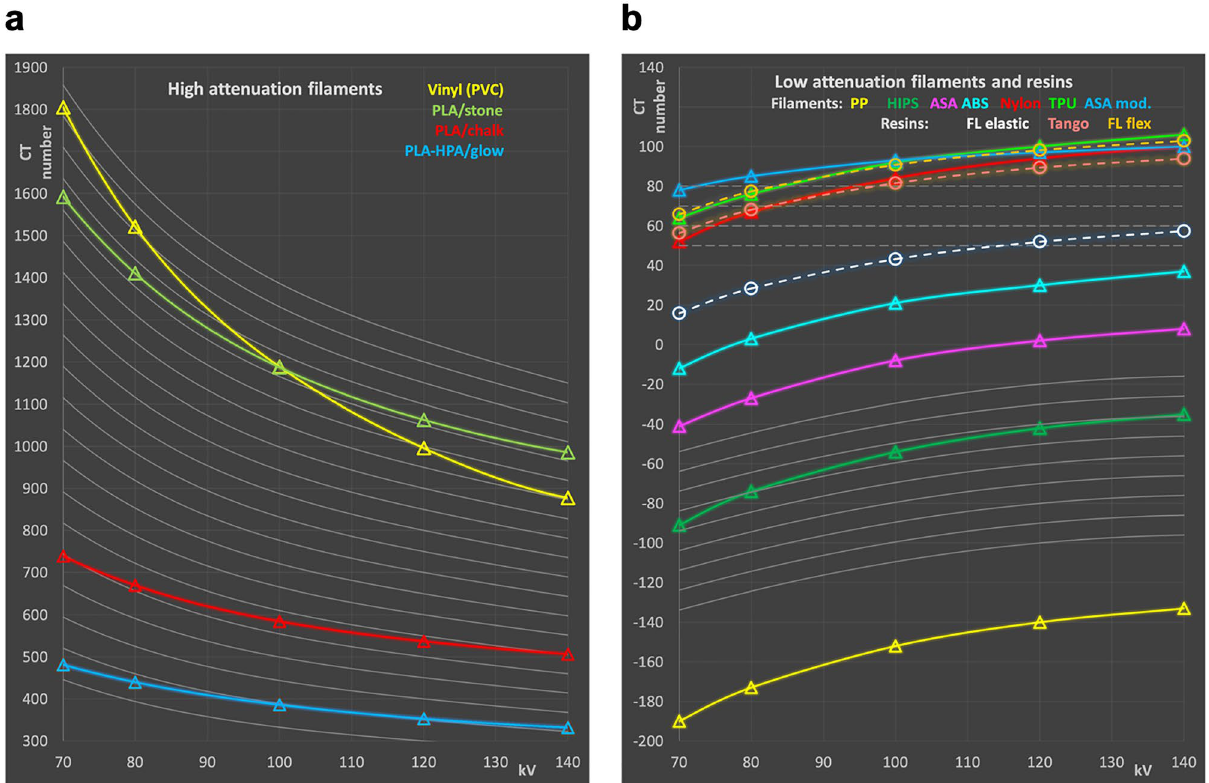
Figure 3. Comparison of 3D printing materials with hard and soft tissues. ( a ) Bone tissue and high attenuation printing materials, and ( b ) soft and adipose tissue and low attenuation filaments. Gray set of curves corresponds to bone tissues with various densities for comparison according to Eq. (1) in panel ( a ), soft (broken gray lines) and adipose tissue (solid gray lines) according Eqs. (3) and (4) respectively, in panel ( b ). Circles connected with broken lines correspond to photocurable resins in panel ( b ) to easily distinguish printing resins from FDM filaments shown as triangles connected by solid